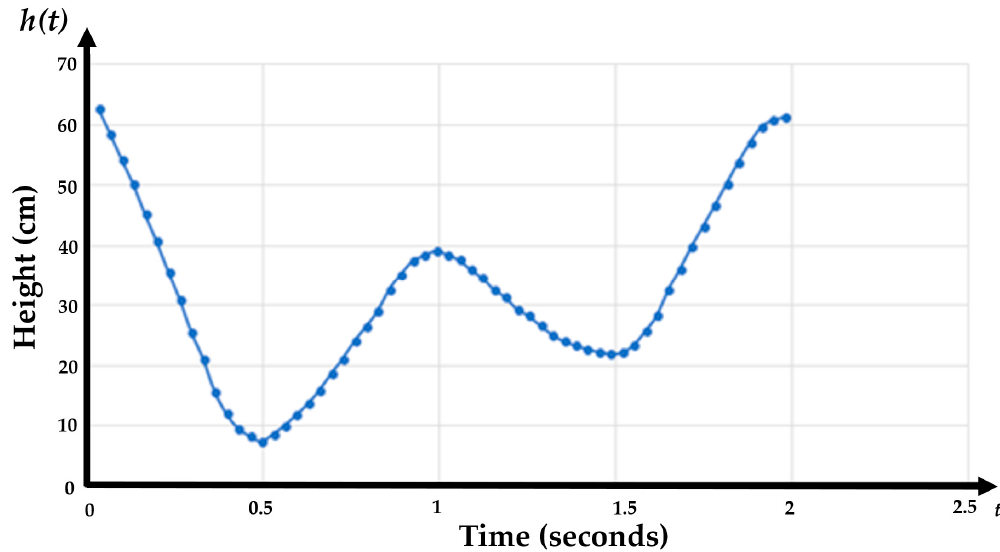
Figure 7. Duple gesture segmentation.